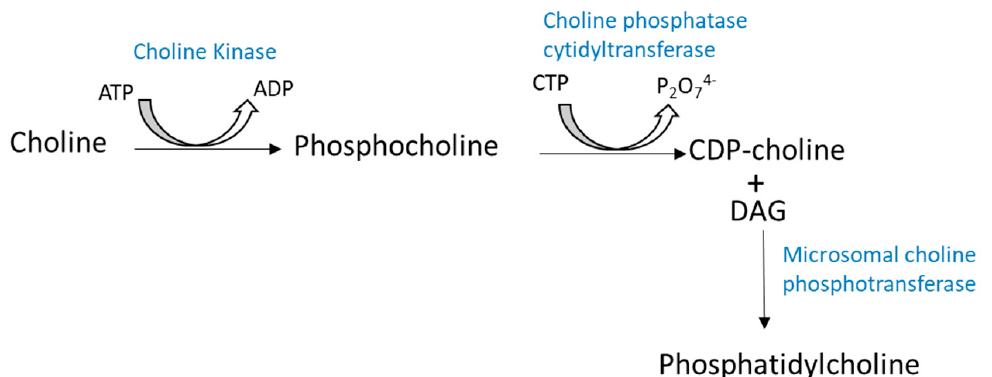
Figure 3. Cytidine diphosphate-choline (CDP − choline) pathway for PC synthesis. Phosphatidylcholine or phosphocholine (PC) is formed from choline in the presence of choline kinase and ATP. Then, PC leads to the formation of CDP − choline with the action of choline phosphatase cytidyltransferase. The last step concerns the combination of both CDP − choline and diacylglycerides (DG) to form PC.